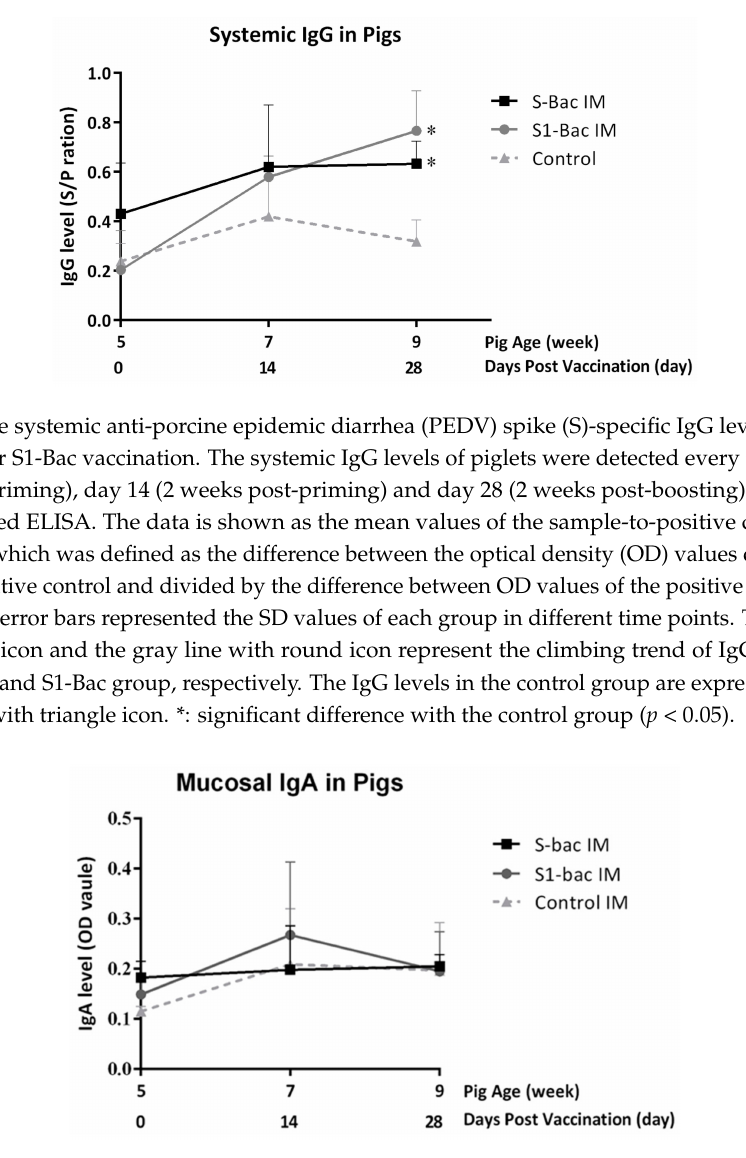
Figure 7. The anti-porcine epidemic diarrhea (PEDV) spike (S)-specific fecal IgA levels in piglets after S-Bac or S1-Bac immunizations. The mucosal IgA levels of pigs were evaluated every two weeks at day 0 (pre-priming), day 14 (2 weeks post-priming) and day 28 (2 weeks post-boosting) from rectal swabs by using PEDV S-based ELISA. The data is presented as mean OD values from five pigs. The error bars represent the SD values of each group at different time points. The solid line with square icons and the gray line with round icons represent the climbing trend of IgA level in the S-Bac group and S1-Bac group, respectively. The IgA levels in the control group is expressed with the dotted line with triangle